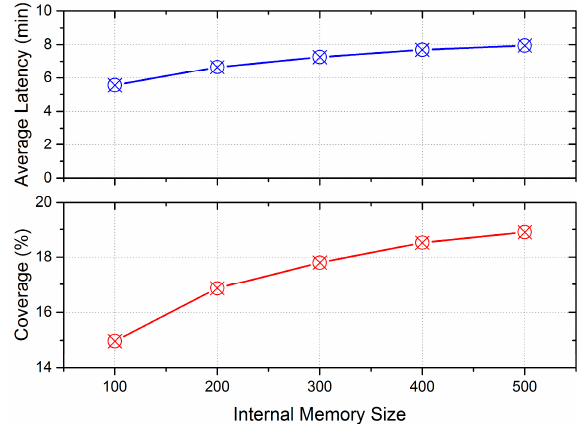
Figure 17. Average latency and coverage of LCODC scheme with different internal memory sizes